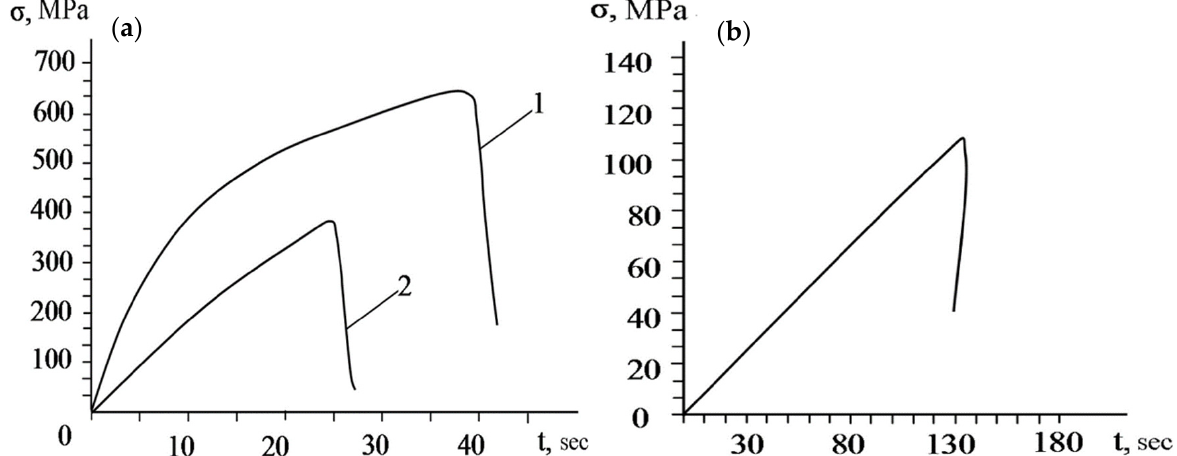
Figure 19. ( a ) Diagram of tensile test specimens with the adhesive strength under shear load and ( b ) curves of tensile specimens cut from the coating produced by supersonic laser deposition in the longitudinal direction (1) and in the transverse direction (2) [96].